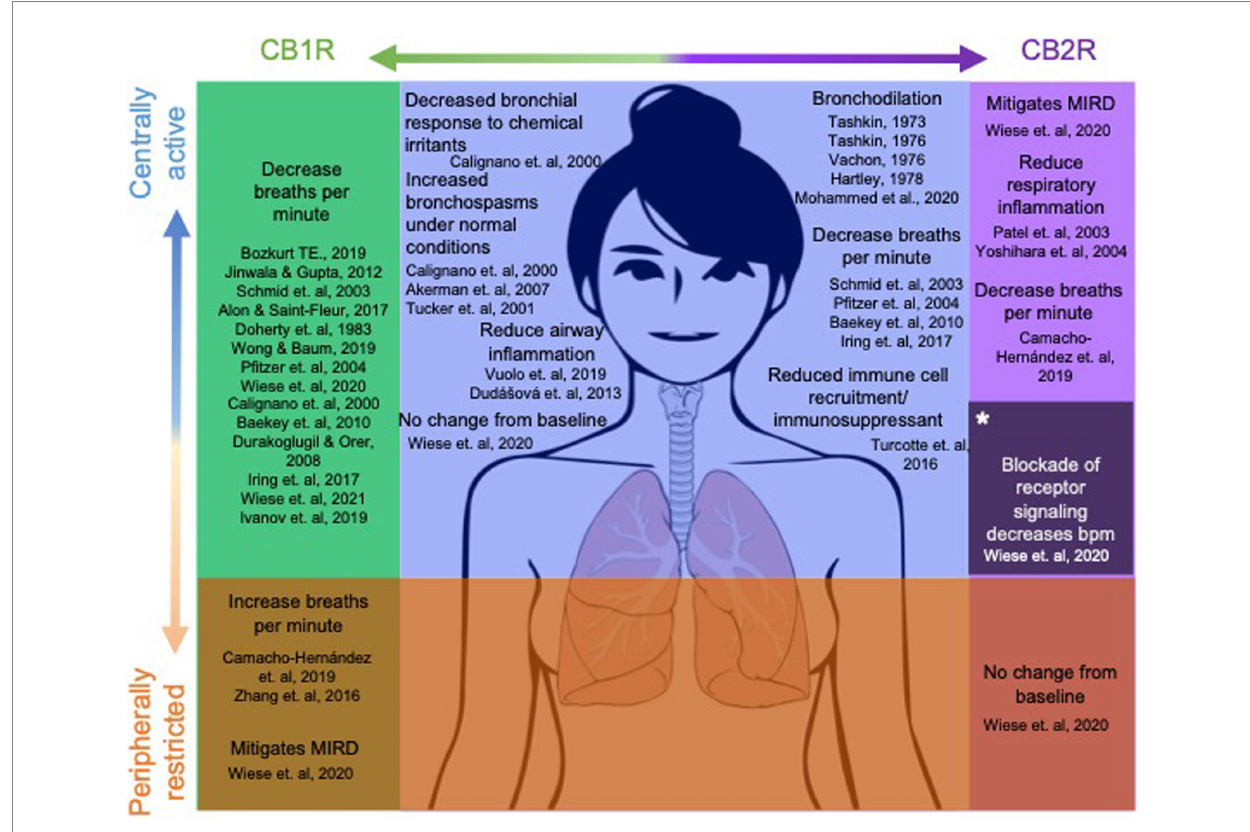
FIGURE 2 CB1/CB2 receptor distribution and current understanding of their role in respiratory function. Dots in the brain represent centrally mediated effects, dots in the lungs and abdomen represent peripherally mediated effects. Dot size corresponds to concentration levels of the receptor within the